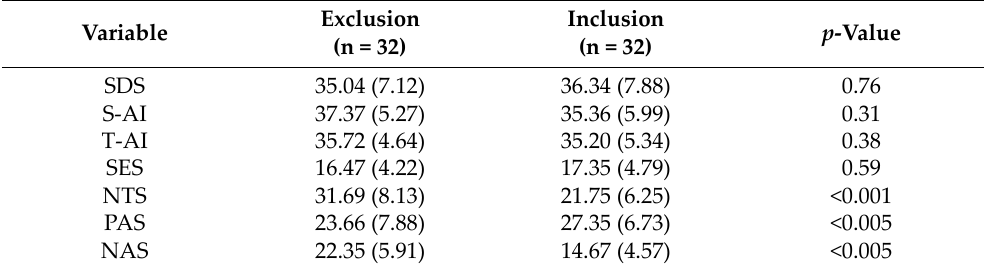
Table 1. Means (and standard deviations) of subjective rating in exclusion and inclusion group.